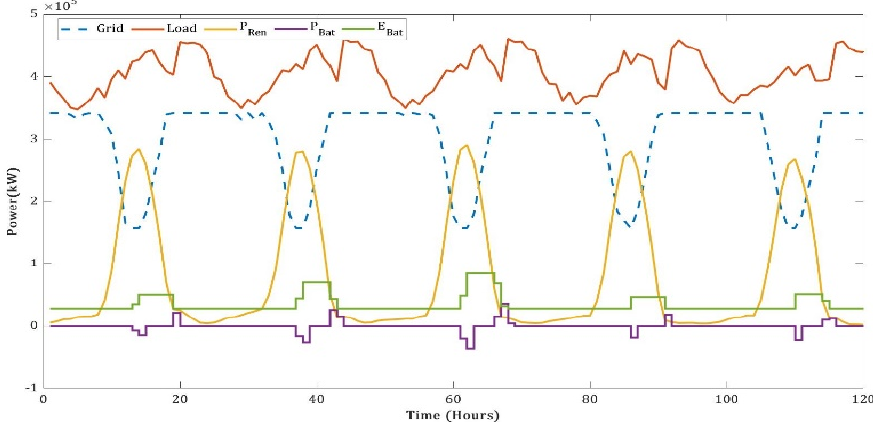
Figure 15. Power distribution with ALA-QPSO for the minimum LPSP for 21–26 September.